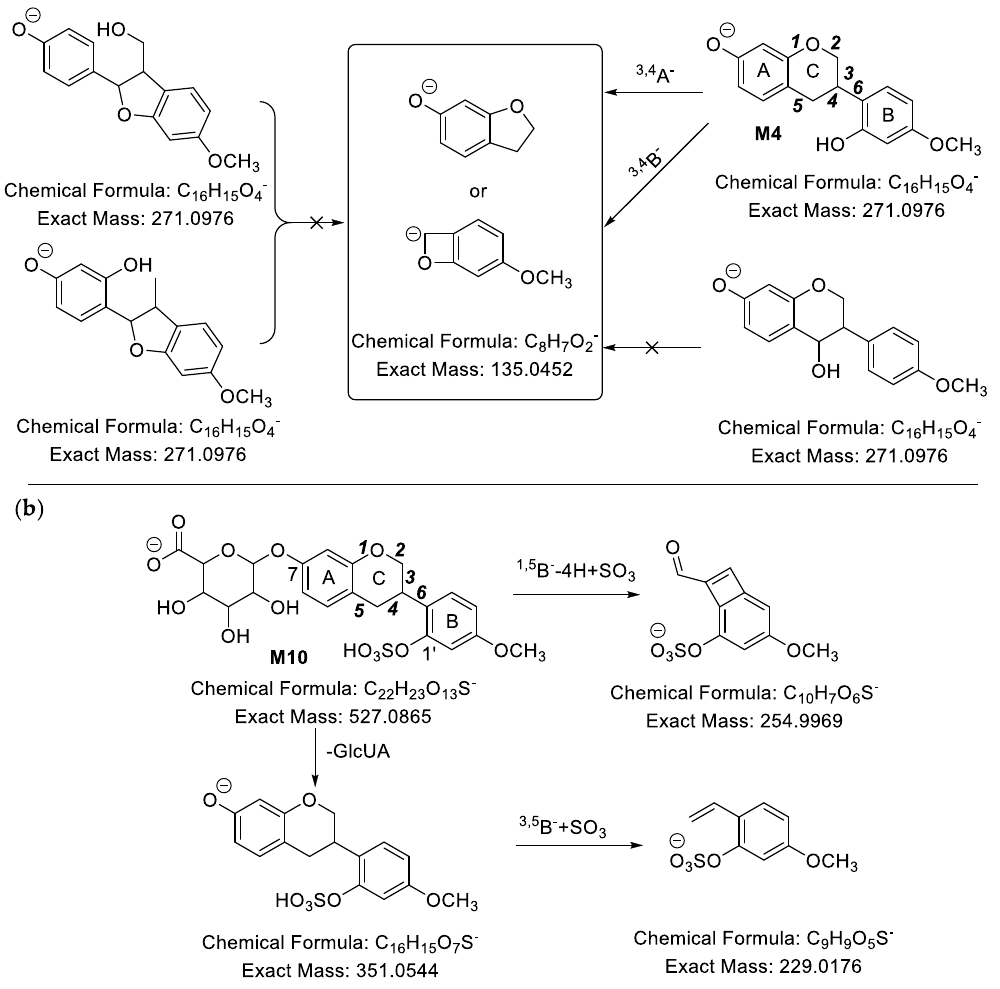
Figure 6. ( a ) The proposed fragmentation pathways of M4 in ESI− mode; ( b ) The proposed fragmentation pathways of M10 in ESI− mode.